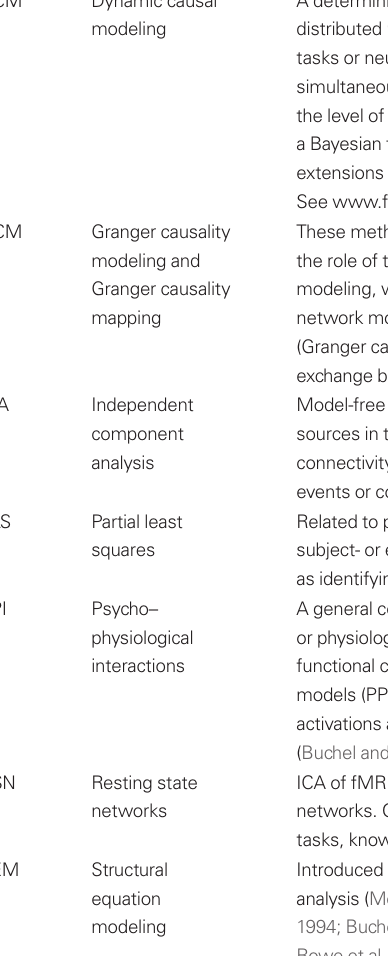
Table 1 | Glossary and outline of methods